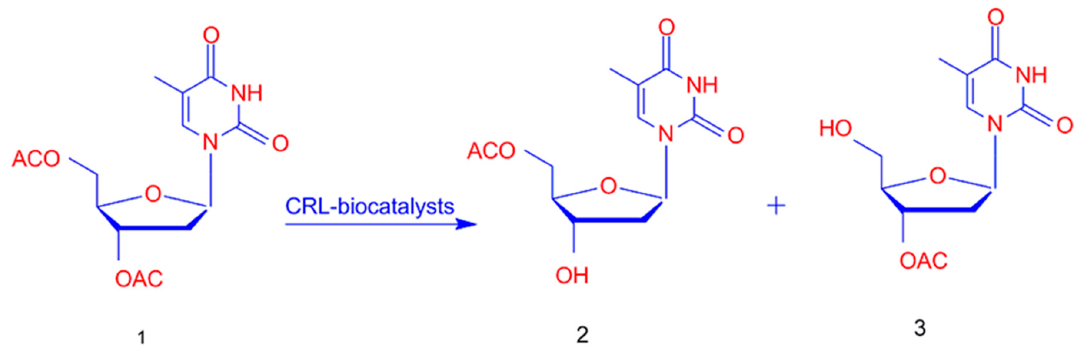
Figure 6. Candida rugosa (CRL) lipase, catalyze regioselective deprotection of 3,5-O- diacetylated thymidine 1 with different aldehyde [108].